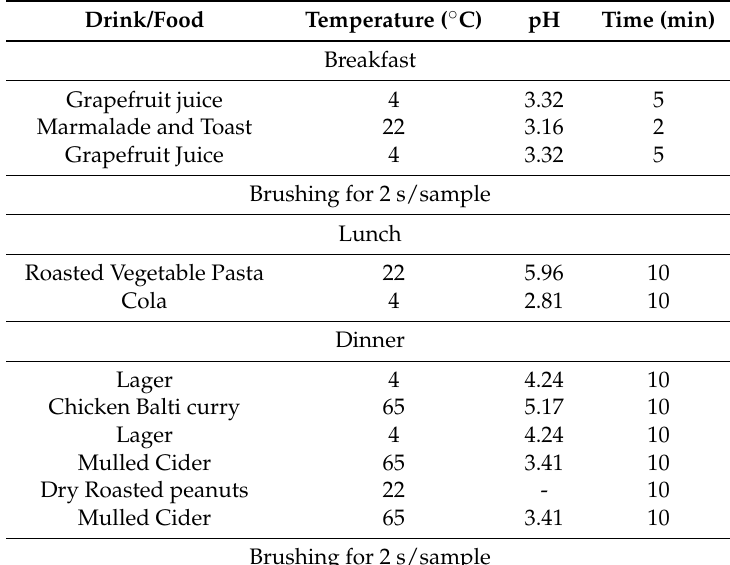
Table 1. The ‘Friday’ diet meal sequence showing pH at temperature and time of exposure. Double lines represent where non-contact profilometry measurements were